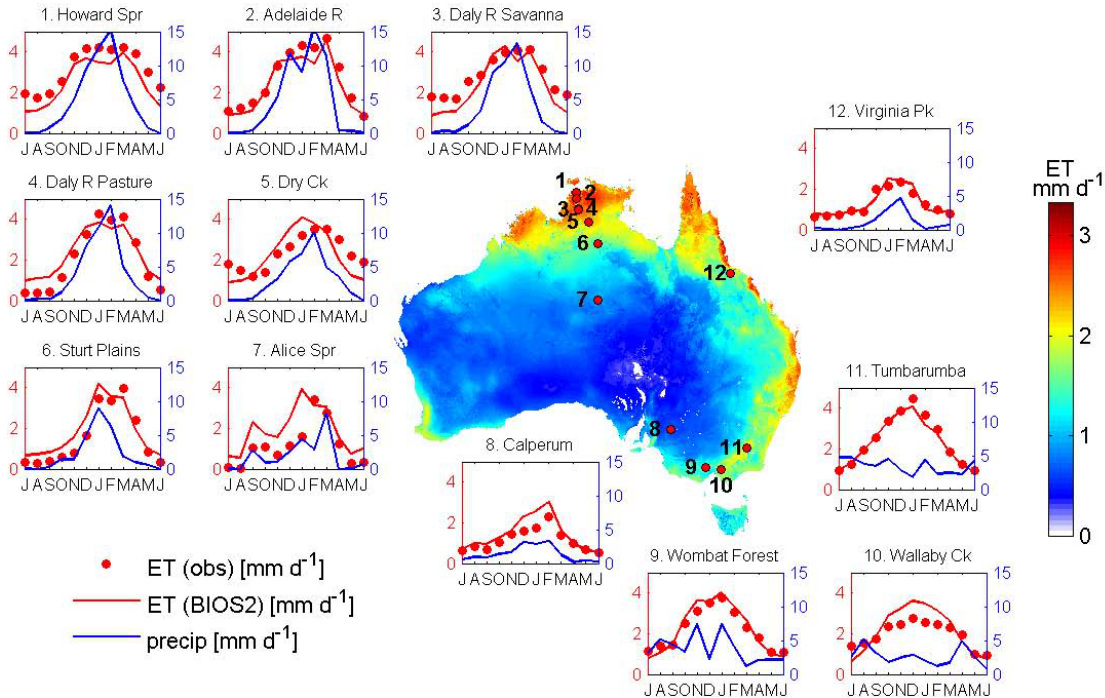
Fig. 5. Mean (1990–2011) ET (map), ensemble monthly mean ET (averaged over years of obs) (BIOS2 and obs, left axis) and gridded precipitation (right axis) at 12 OzFlux sites.